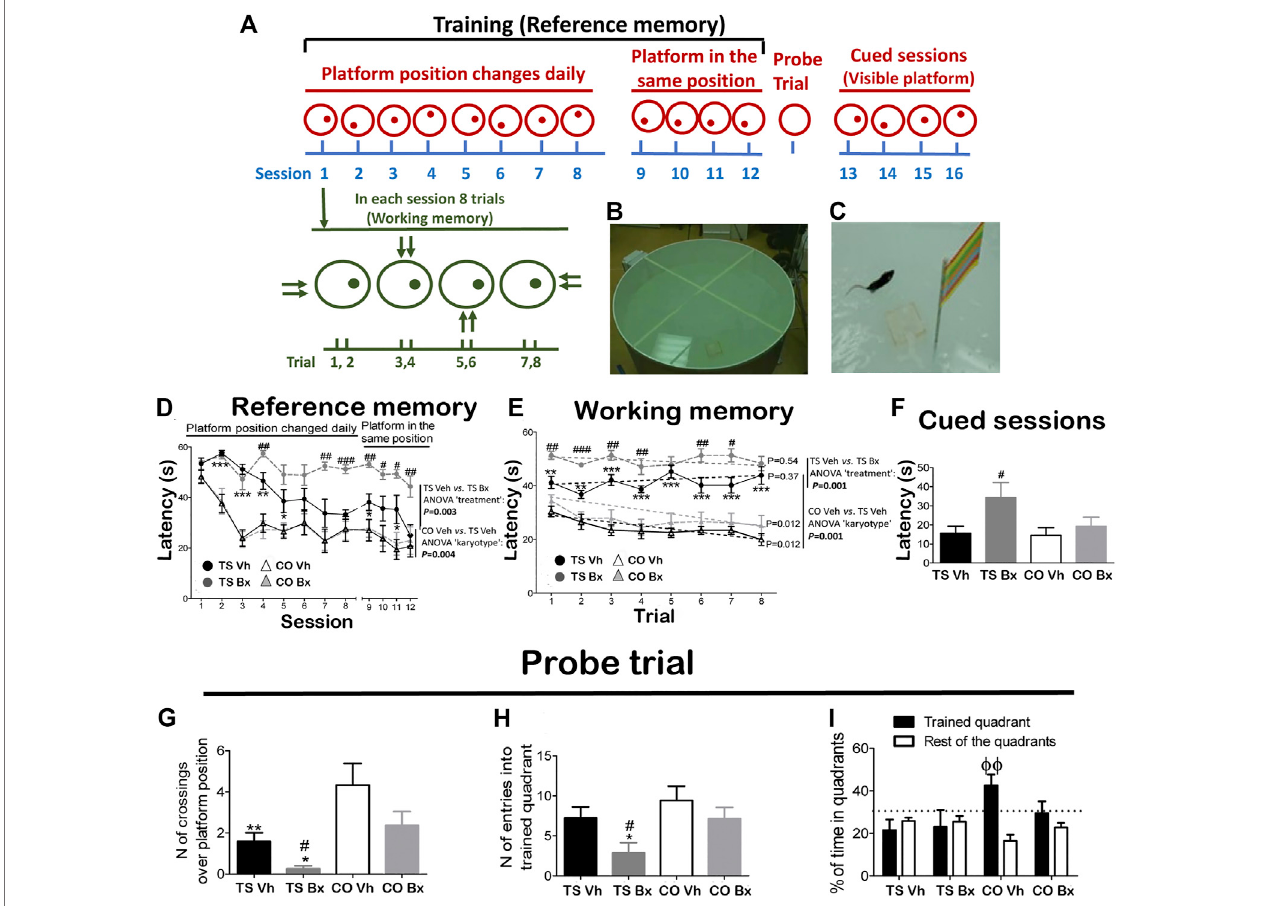
FIGURE1| Schematic drawing oftheMWMprotocol (A) , and representative image oftheapparatusduringthe training (B) , andcued (C) sessions. Mean ± S.E.M of the latency to reach the platform during the twelveacquisition sessions (D) , during each trial of the fi rst eight acquisition sessions (E) , and mean latencies to reach the platform during the four cued sessions (F) , of the number of crossings over the platform position (G) , the number of entries in the trained quadrant (H) , and the mean percentageoftimespentinthetrainedquadrantvs.themeantimespentintherestofthequadrants (I) ,duringtheprobetrialbyTSandCOmiceunderbexarotene or vehicle treatment. *: p < 0.05, **: p < 0.01,***: p < 0.001:TSVh vs. COVhor TSBxvs. COBx;#: p < 0.05, ##: p < 0.01, ###: p < 0.001 TSBxvs. TSVh; ϕϕ : p < 0.01 trained quadrant vs. rest ofthe quadrants. Fisher ’ s LSD post-hoc tests. On the right side of the A and B fi gures, the p -value of the differencebetween the TS Bx and the TS Vh, and between the TS Vh and CO Vh learning curves across the twelve sessions (RM ANOVAs) is shown. In the B fi gure, the dotted lines and the p -values beside themrepresentthesigni fi canceofthechangeinlatencyacrossthetrials(RMANOVA ‘ trial ’ ofeachlearningcurve).Thedottedlinesin fi gureCrepresentthechancelevel, i.e. a probability equal to